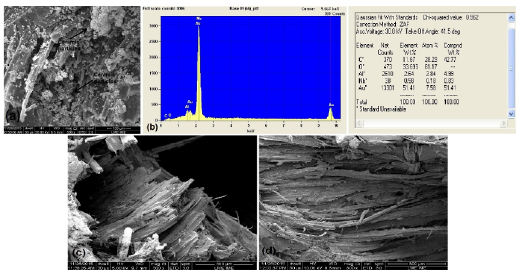
Figure 5. SEM micrographs of the fractured composites after the ballistic test. (a) 100% mallow fabric (b) EDS of 100%